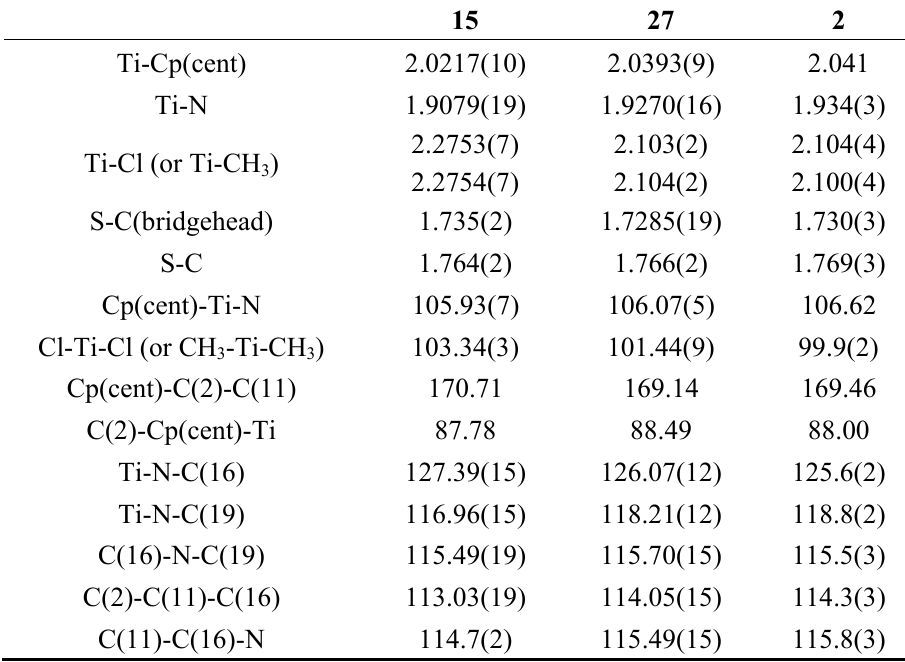
Table 1. Selected bond distances (Å) and angles (°) in 15 , 27 , and 2